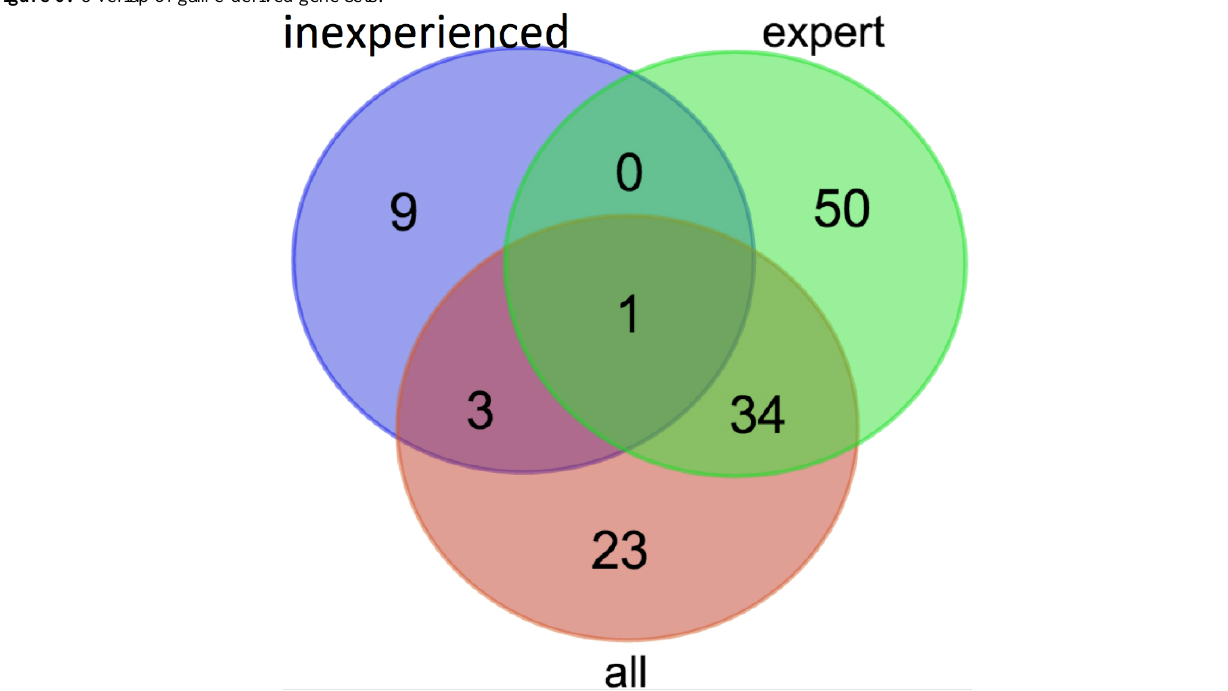
Figure 6. Overlap of game-derived gene sets.